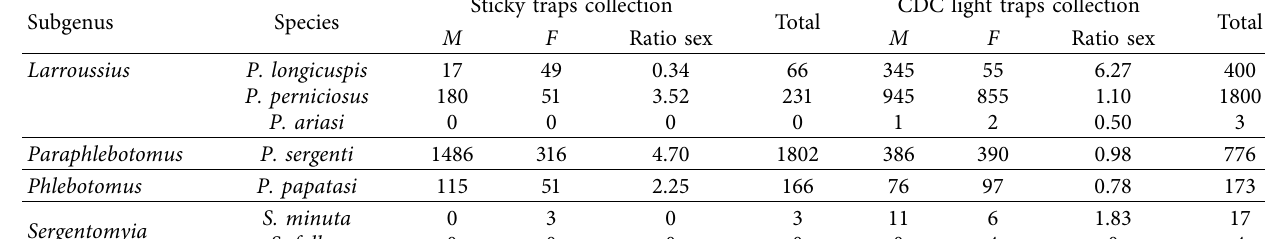
Table 1: Sand fly species composition in Aichoune.